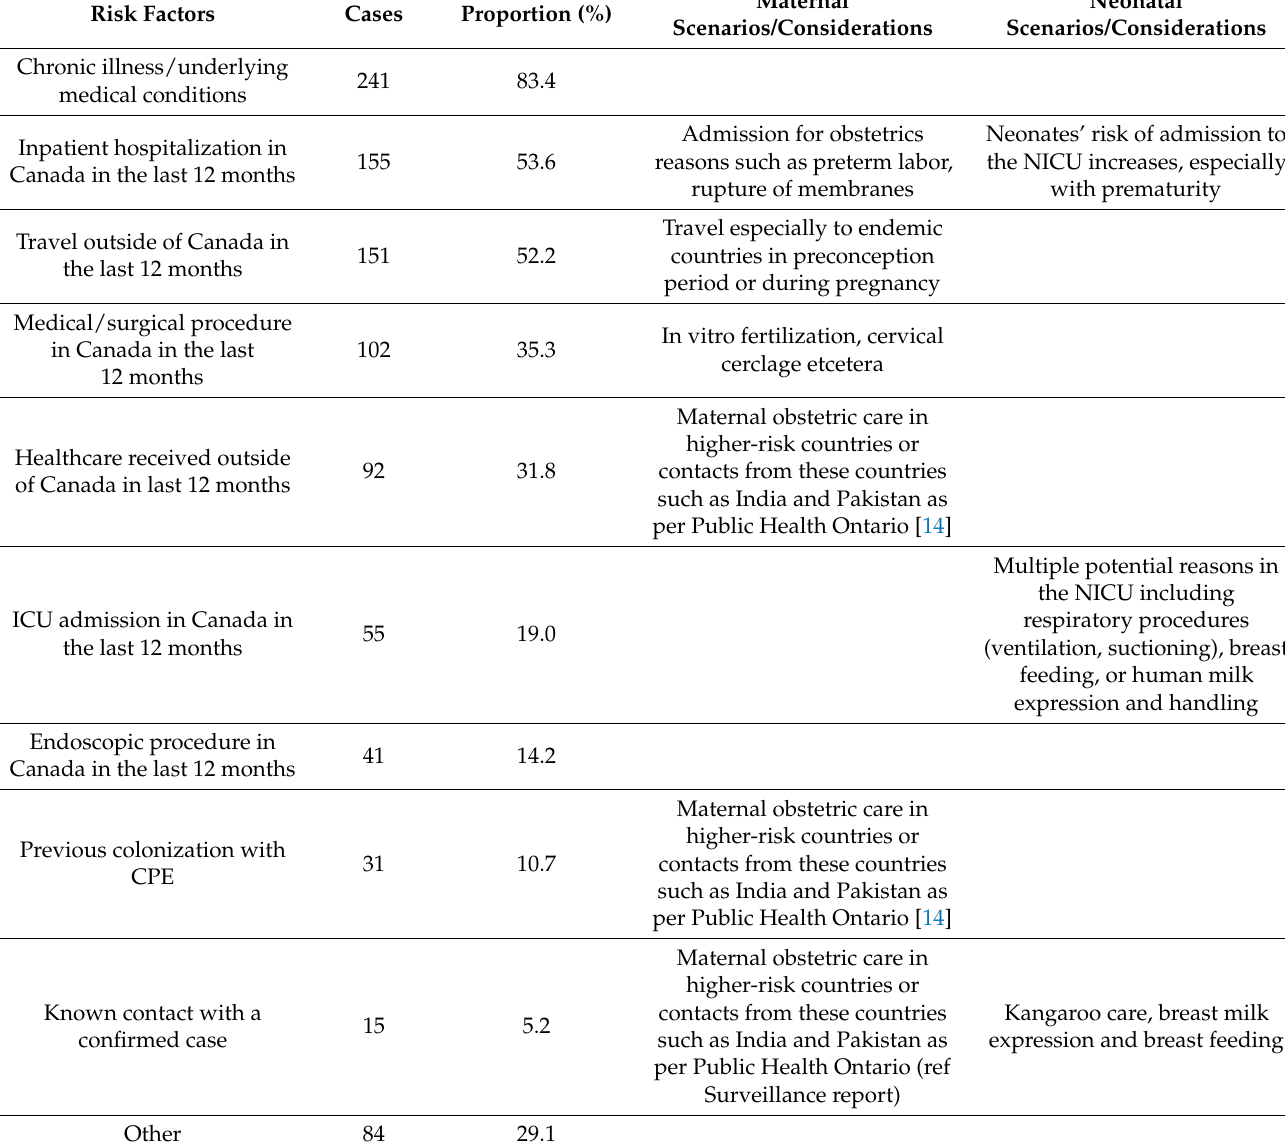
Table 1. Risk factors for CPE cases in Ontario, May 2018 to April 2019 ( n = 289). Clinical aspects related to maternal and newborn